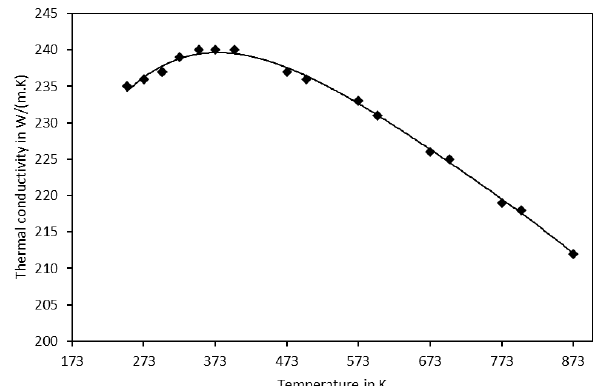
Figure A2. Aluminum thermal conductivity data from Hatch [43] and correlation.